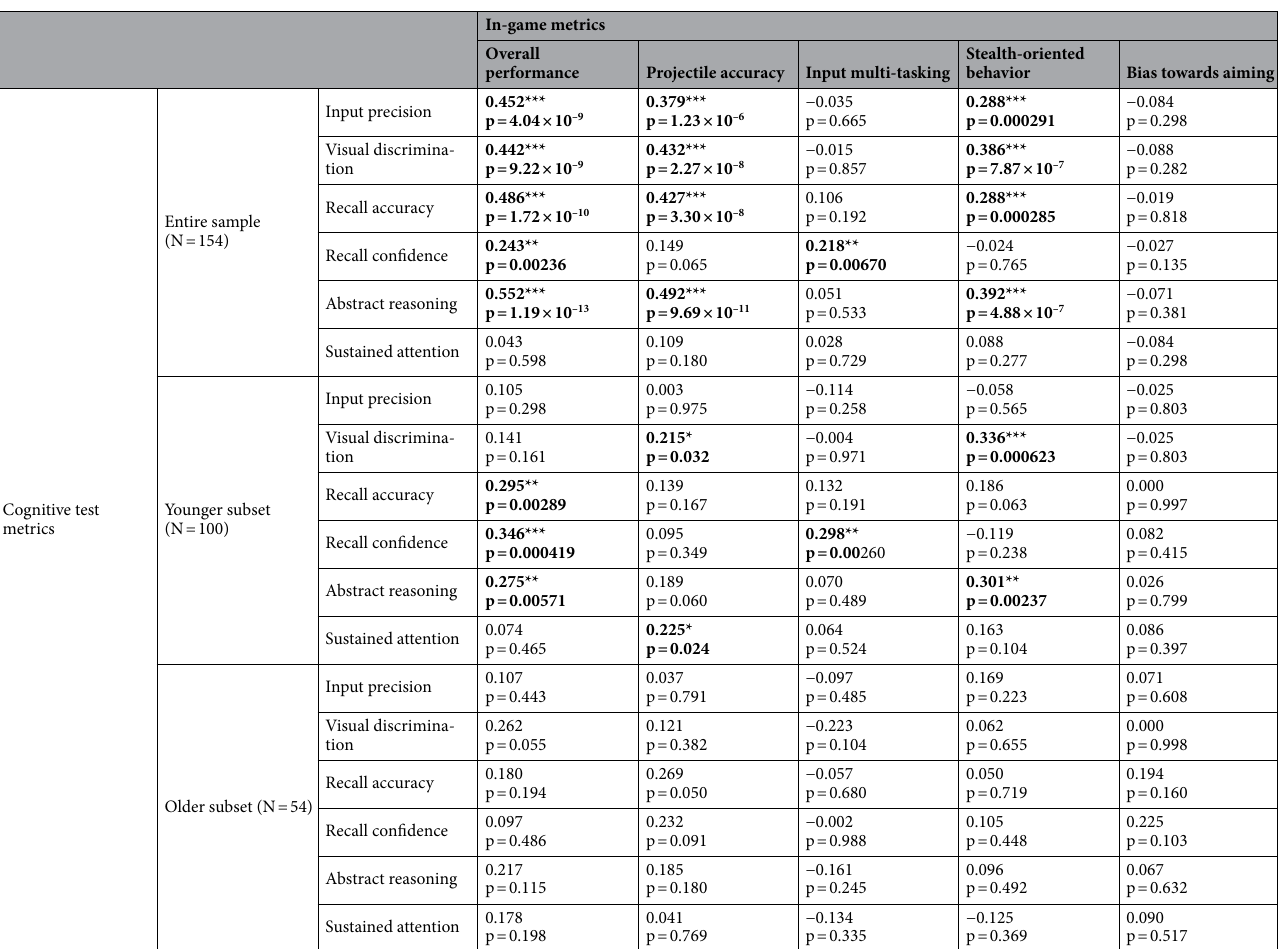
Table 1. Table of correlations (Pearson’s correlation) between in-game metrics and cognitive test metrics (significance *p < 0.05, **p < 0.01, ***p < 0.001, significant cells with bold values) for the entire player sample for which metrics could be computed (N = 154 for entire sample, N = 100 for younger group, N = 54 for older